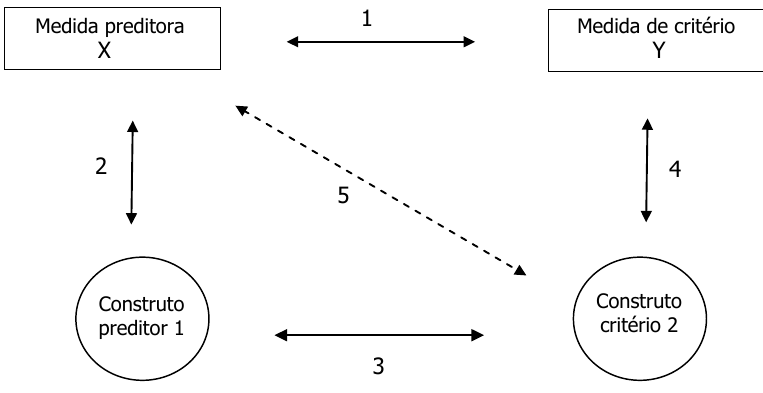
Figura 1 . Relações entre construtos e medidas - Adaptado de Binning e Barrett (1989) e SIOP,